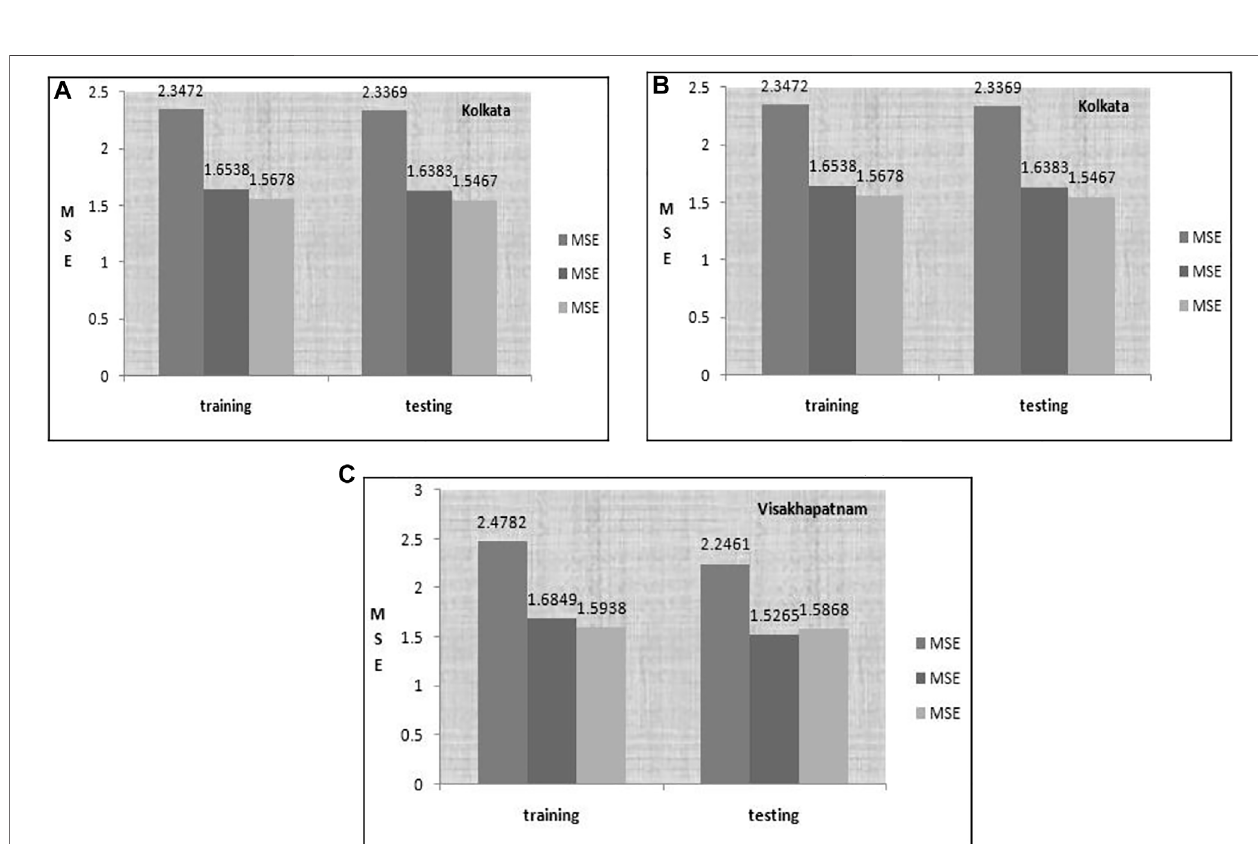
FIGURE 14 | (A – C) MSE ( MJ / m 2 ) for the most appropriate blend of parameters with one, two, and three inputs of Bhubaneswar city during training and testing.